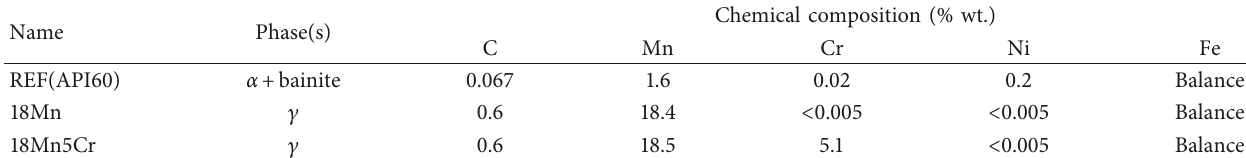
Table 1: Chemical composition of the experimental